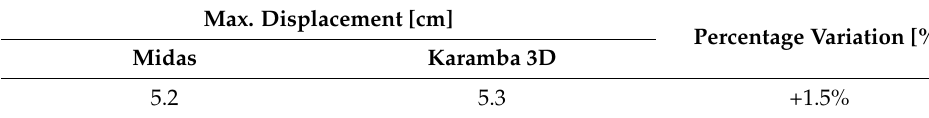
Table 1. Maximum bridge displacement in nodes subject to higher stresses.